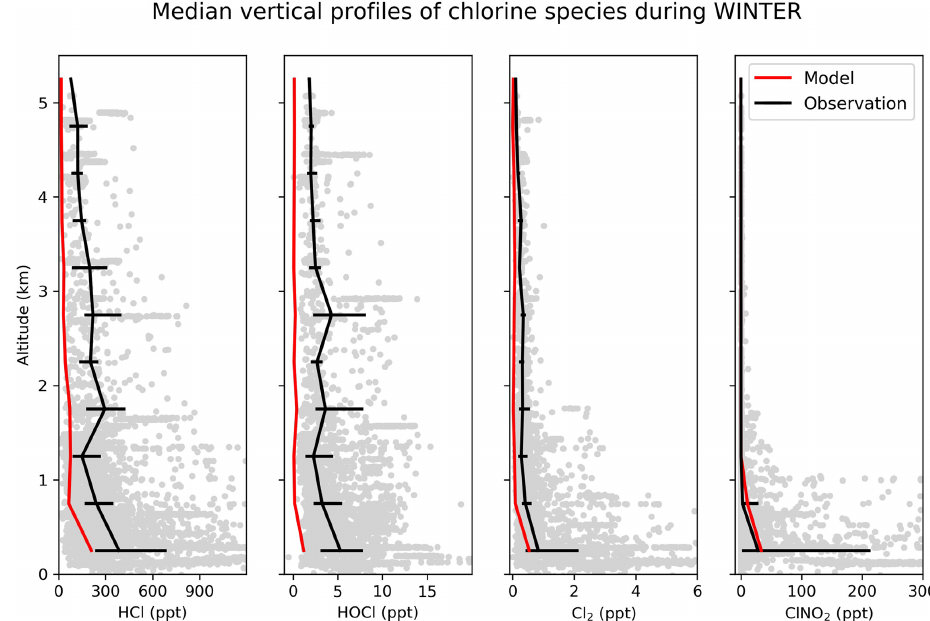
Figure 9. Vertical profiles of HCl, HOCl, Cl 2 and nighttime ClNO 2 mixing ratios during the WINTER campaign over the eastern US and offshore in February–March 2015. Observations are shown as individual 1min data points, with medians and 25th–75th percentiles in 500m vertical bins. ClNO 2 data exclude during the daytime (10:00–16:00LT), when mixing ratios are near zero in both the observations and the model. Model values are shown as medians sampled along the flight tracks.